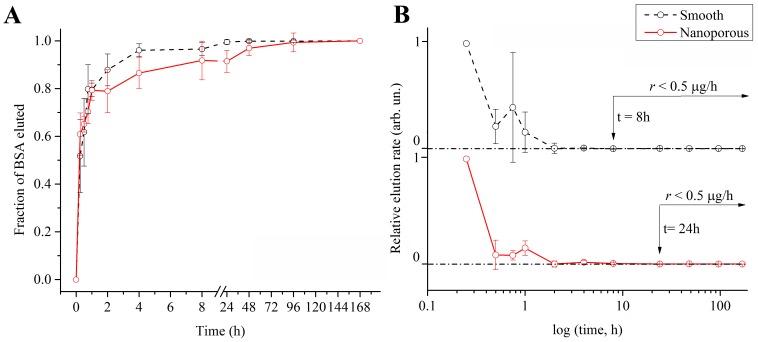
Point-by-point curves of the fraction eluted (A) and relative elution rate (B) of bovine serum albumin adsorbed onto smooth (solid black line, n = 4) and nanoporous (solid red line, n = 6) surfaces.Dotted line in B represents the plateau of no significant elution (i.e. elution rate<0.5 μg/h). Data points are visualized as mean values with standard deviation.